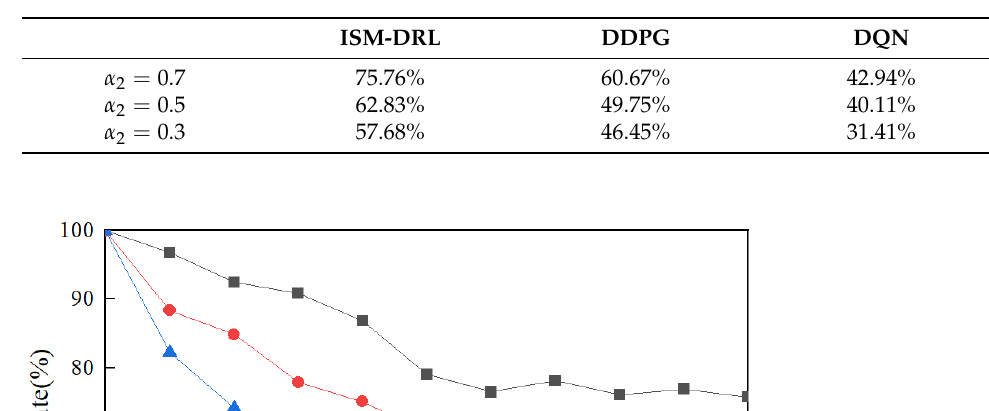
Table 6. Average mapping rate at T = 500.